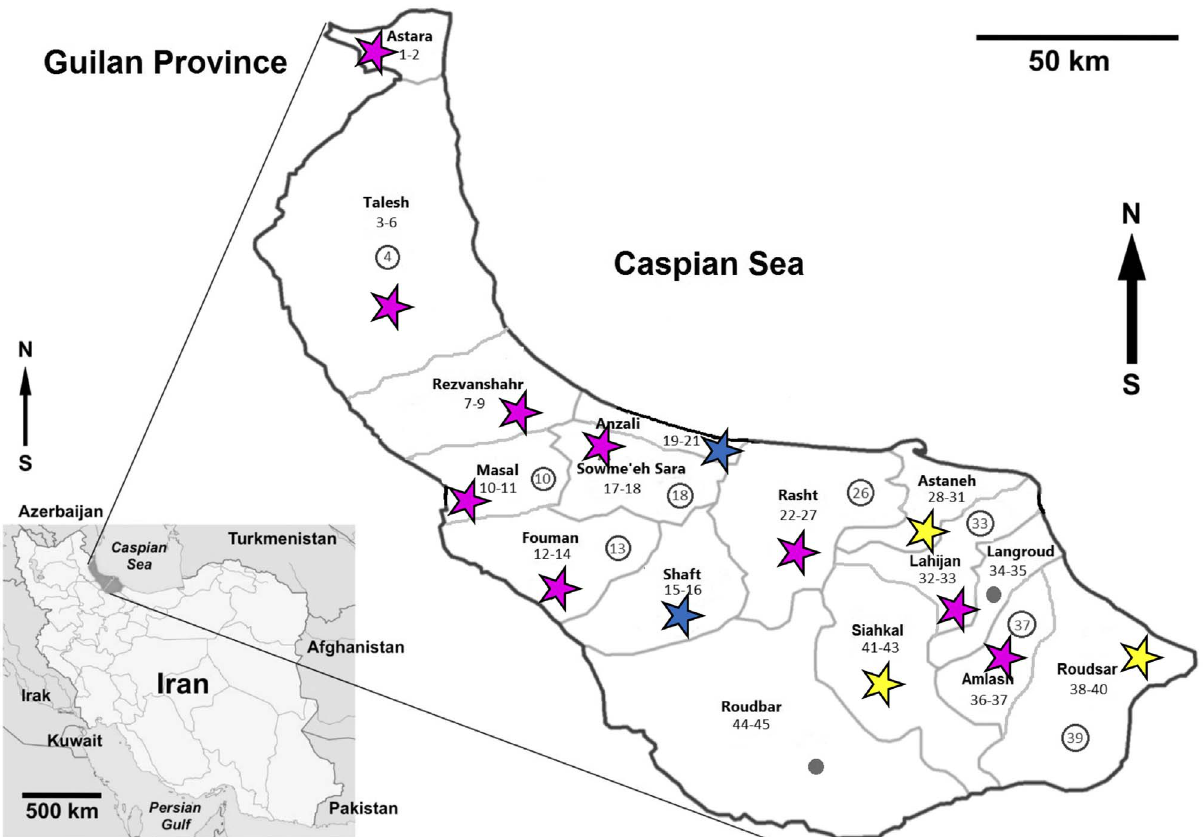
Figure 1. Map of Iran with Guilan province highlighted, showing collecting localities. Pink stars = provinces with positive ducks for both T. franki and T. regenti , and in some cases co-infections; Yellow stars = provinces with positive ducks for only T. franki ; Blue stars = provinces with positive ducks for only T. regenti ; Circles without numbers = areas with negative ducks; and Circles with numbers = localities from which worms were used for